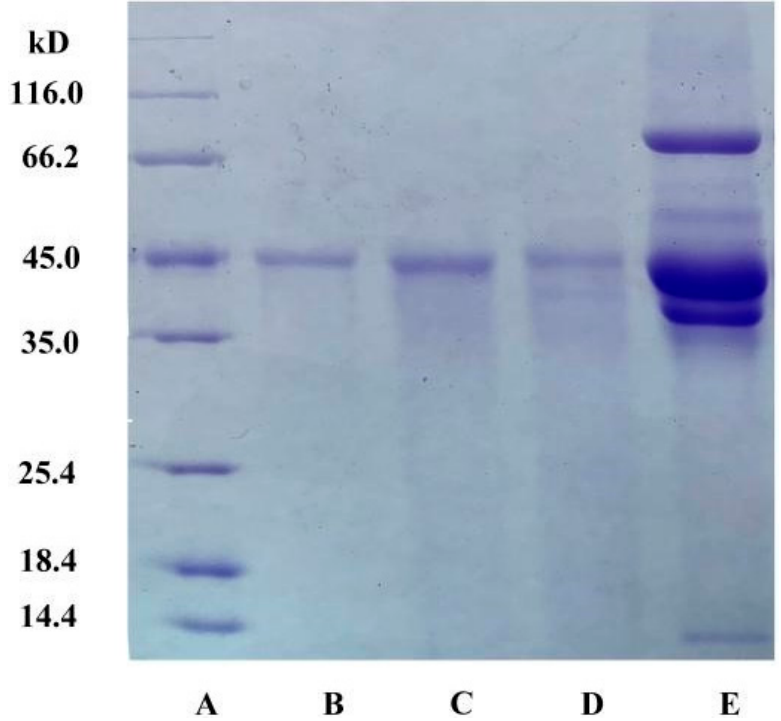
Figure 3. SDS–PAGE of OVA. ( A ) molecular mass standards; ( B ) sample (10 µ g) extracted by ATPS; ( C ) sample (20 µ g) extracted by ATPS; ( D ) OVA standard (10 µ g); ( E ) the salted egg white solution (10 µ g).